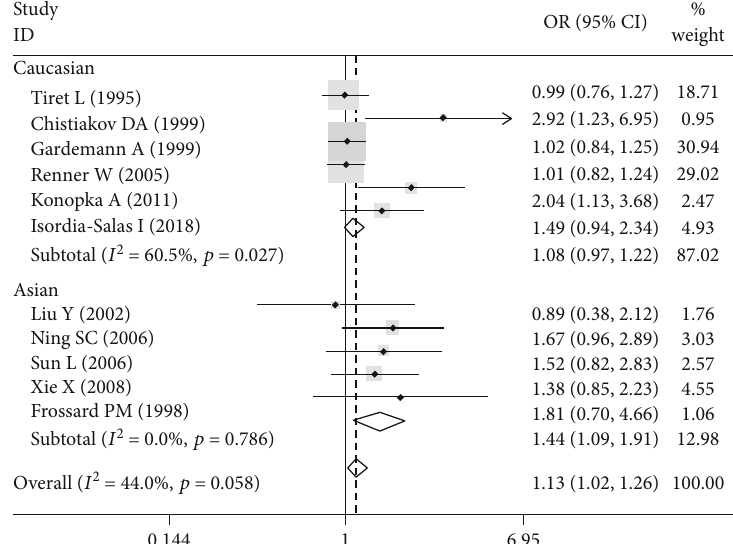
6.945, P = 2 : 60 × 10 − 6 , P